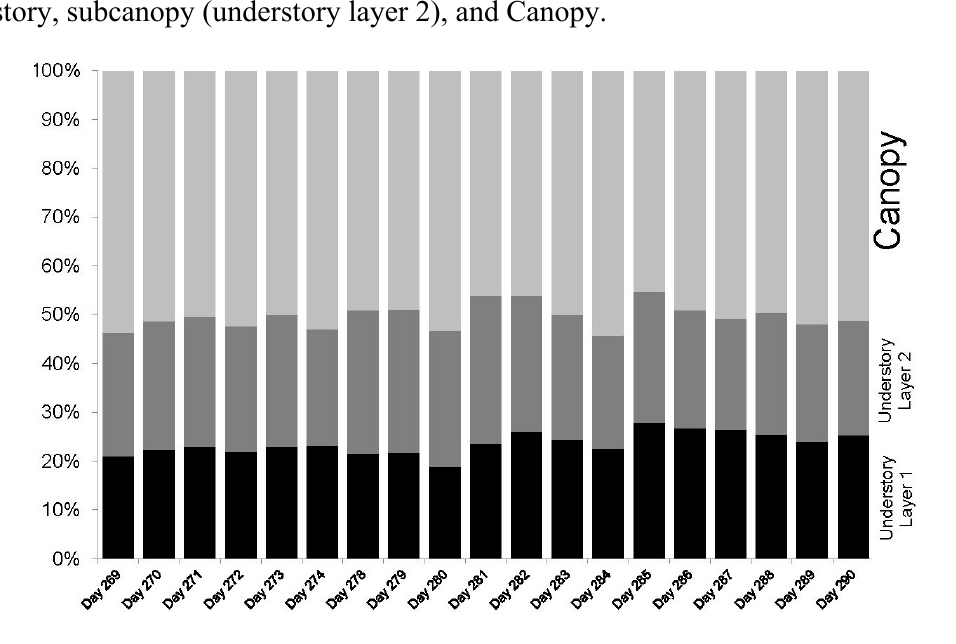
Figure 7. Time-series of the percentage contribution of Canopy, Subcanopy (understory layer 2) and understory (understory layer 1) to the maximum cumulative Plant Area Index (PAI) calculated by the VEGNET IML during September 26 and October 17, 2013 for